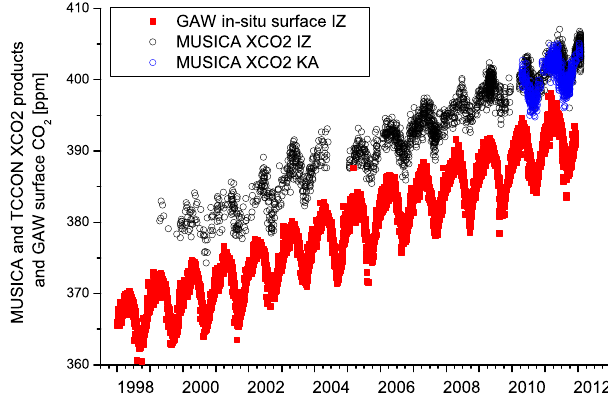
Fig. 10. Time series of XCO2 data obtained from the mid-infrared spectra recorded at Iza˜na (black circles) and Karlsruhe (blue cir- cles). For comparison, the Global Atmospheric Watch (GAW) Iza˜na surface in-situ CO 2 observations are shown (red squares).